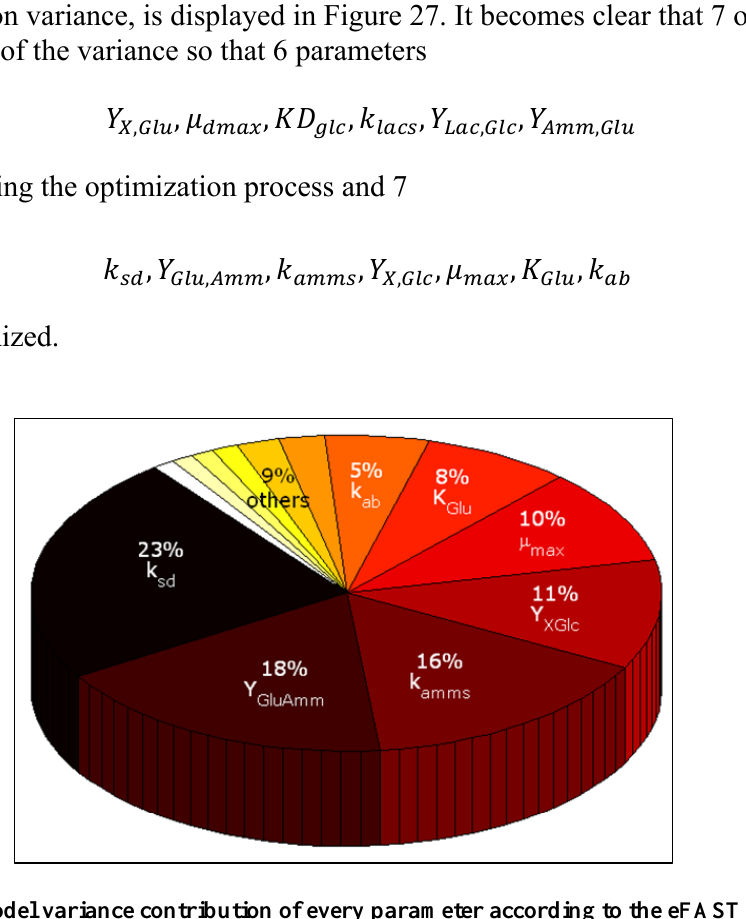
Figure 27: Model variance contribution of every parameter according to the eFAST